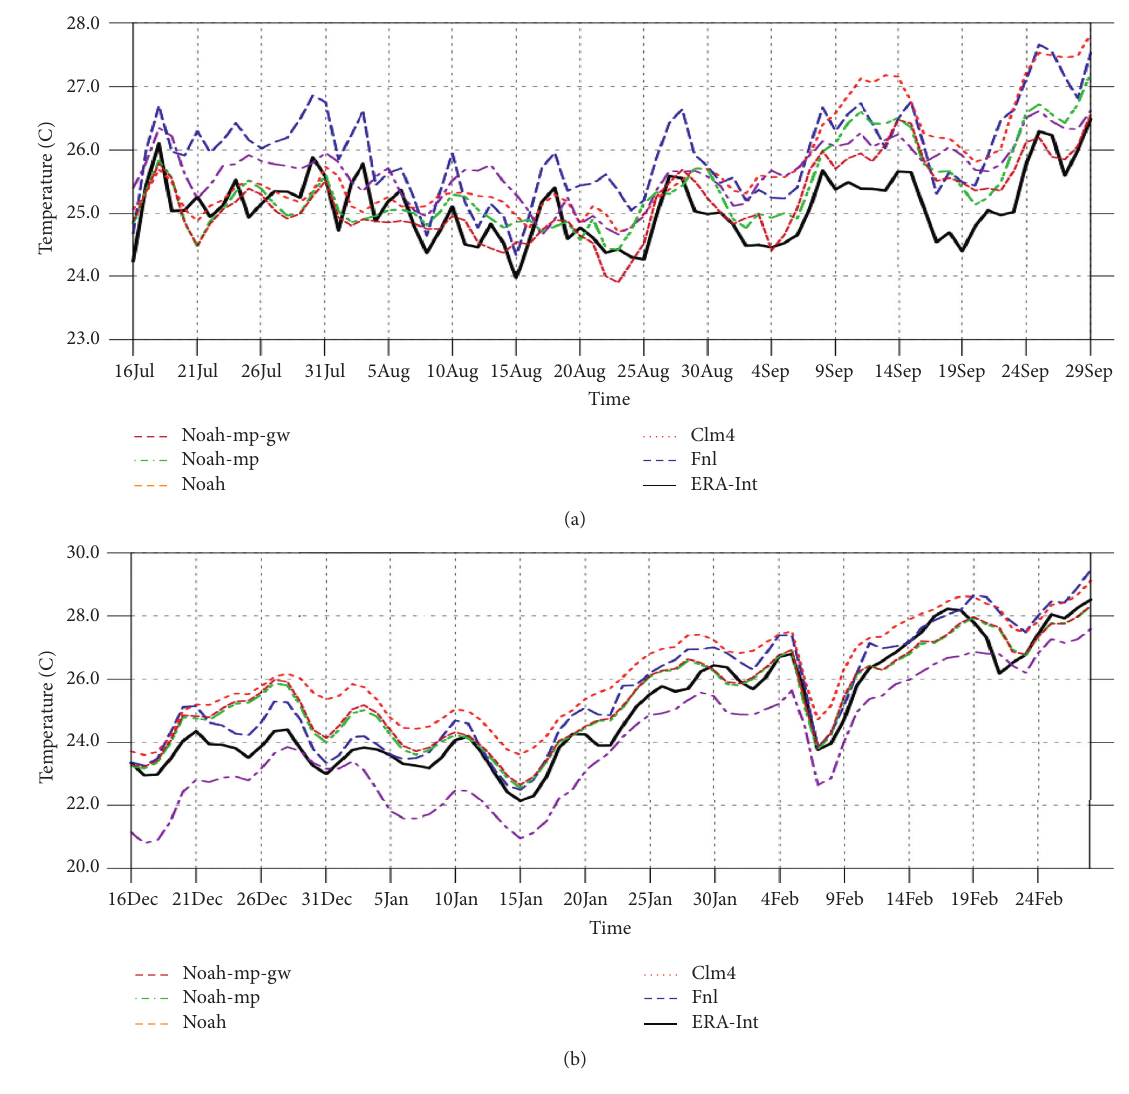
Figure 6: Time series of daily 2m temperature averaged over 10 ° W–10 ° E and 5 ° –15 ° N: (a) JAS; (b)